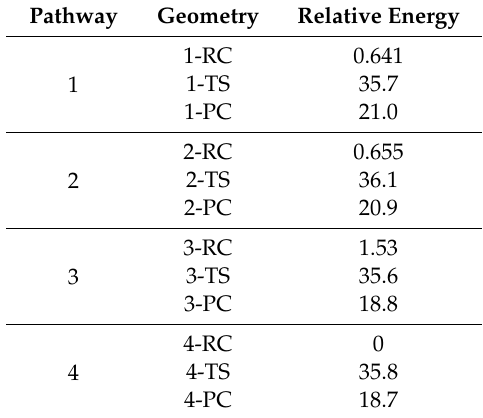
Table 1. Relative energies of optimized geometries, which are shown in kcal · mol − 1 and were corrected for zero-point energies after being calculated at the B3LYP / 6-31 + G(d,p) level of theory. Pathway Geometry Relative Energy 1